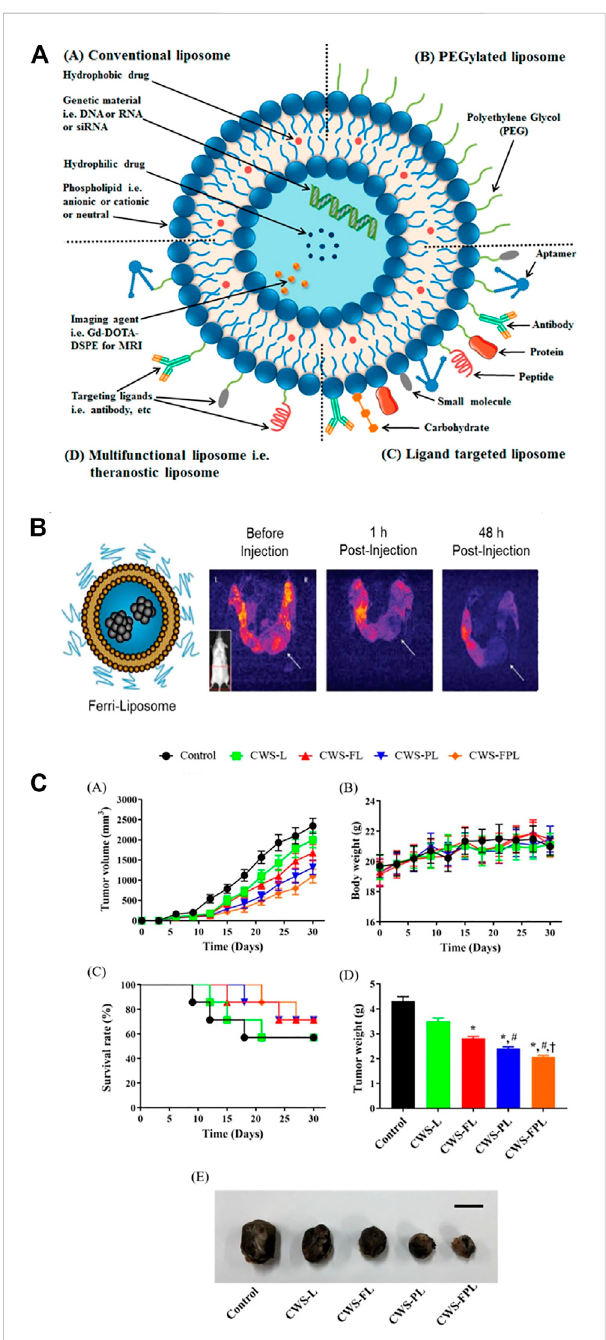
FIGURE 5 Liposomes have been used for cancer diagnosis and therapy. (A) A speci fi c targeting ligand was incorporated to modify the surface of PEGylated liposomes. (B) T2-weighted MR images of a transgenic mouse before and after injection of Ferri-liposomes. (C) An in vivo study indicated that various liposomal formulations inhibited tumor